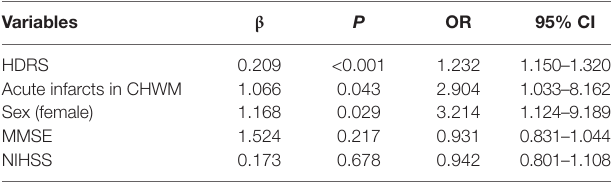
TABLE 4 | Correlates of PSA at 3 months after stroke.